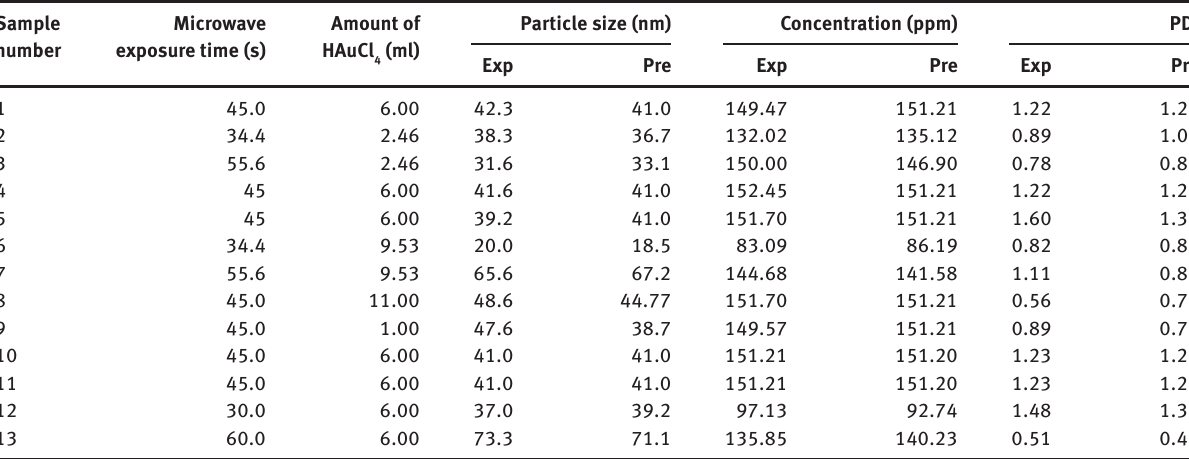
Table 1: Experimental runs according to the central composite design and response variables for AuNP synthesis. Sample number